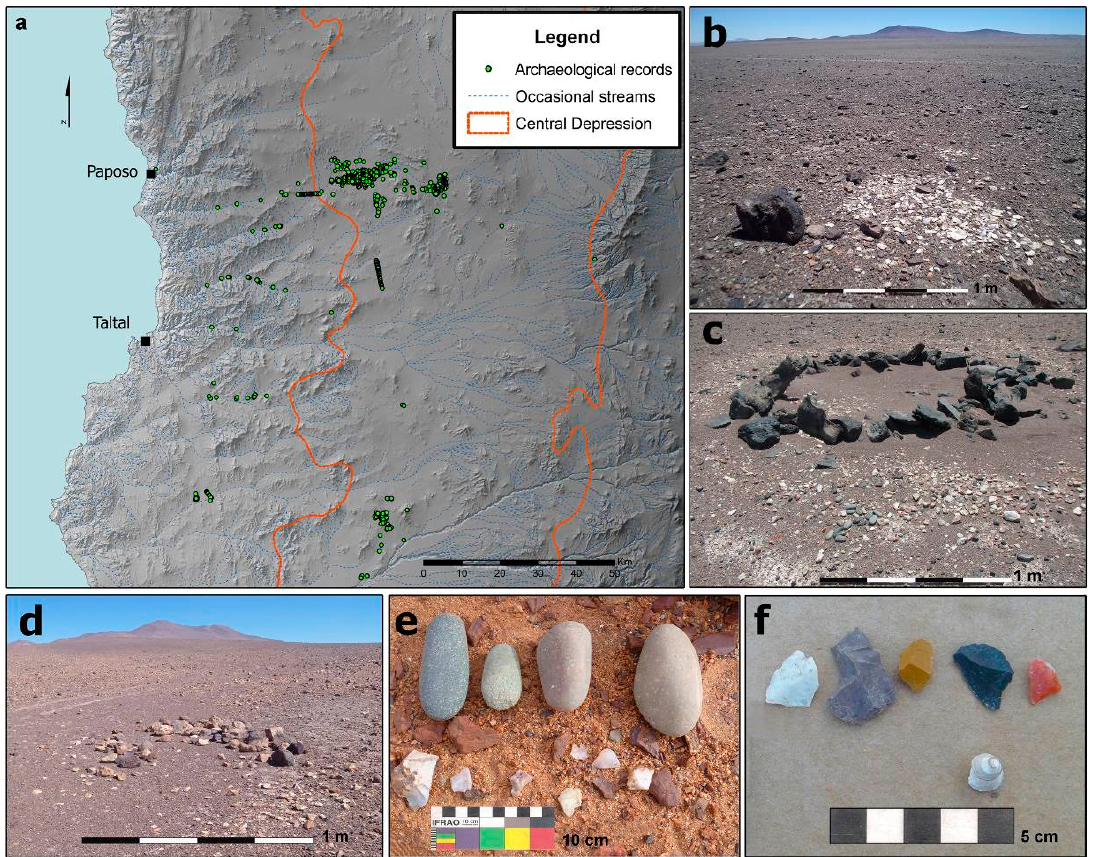
Figure 3. DEM of the study area showing the points of archaeological interest of the interior desert (green dots), the limits of the Central Depression (orange lines), and occasional streams (blue lines); ( b ) to ( f ) material assemblages of ephemeral prehistoric occupations in the core of the Atacama Desert.